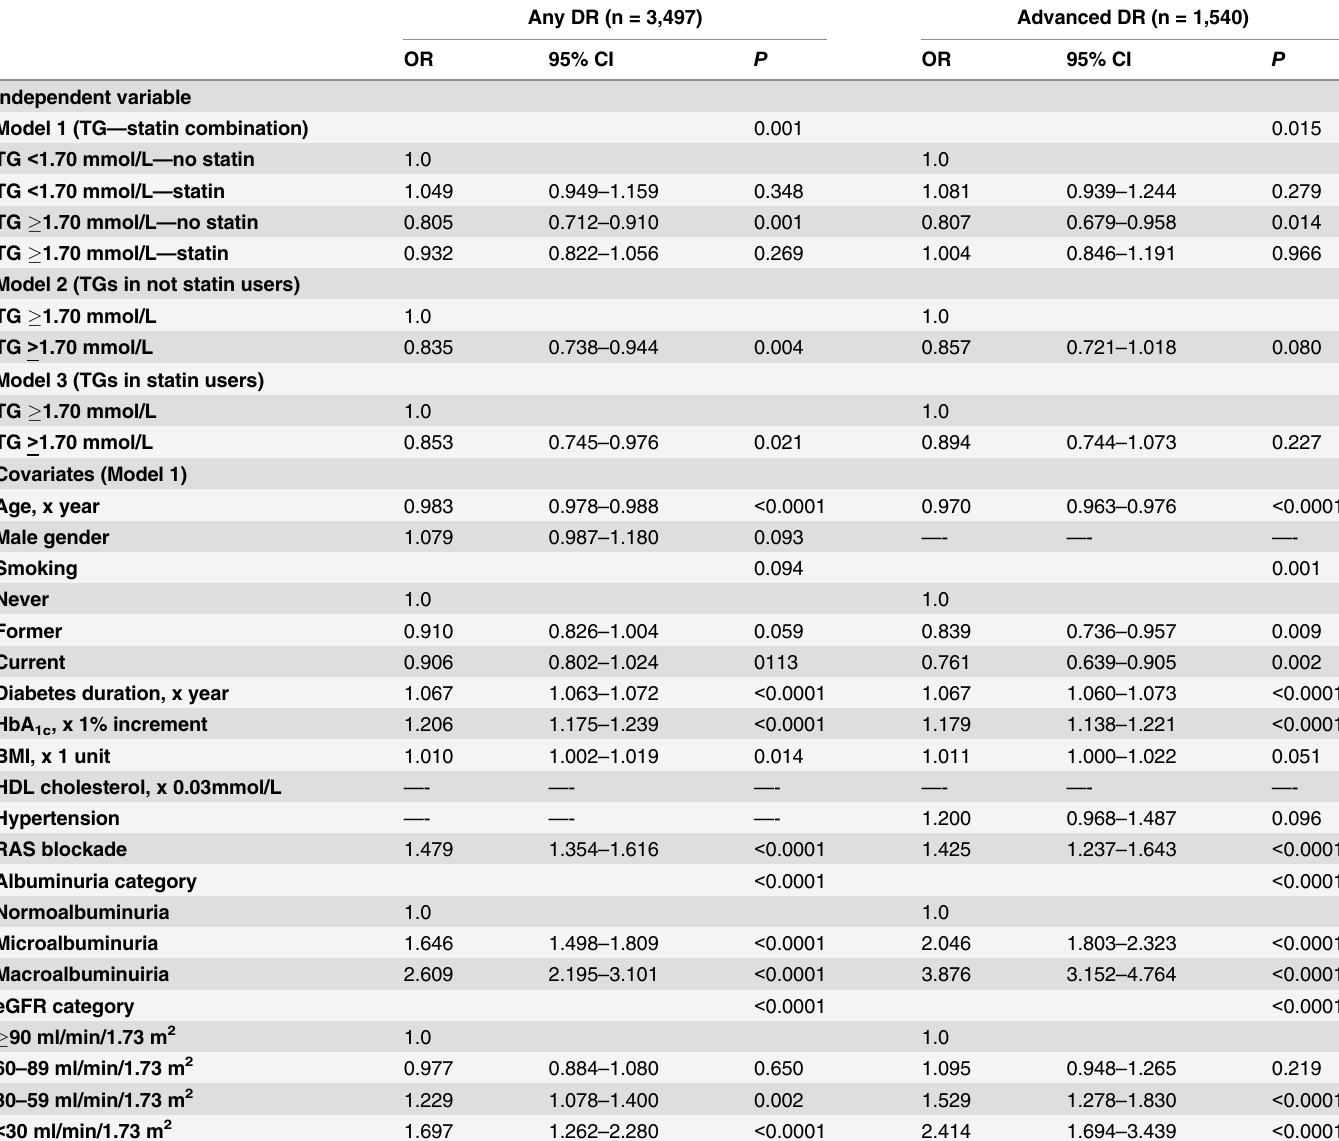
Table 4. Independent association of triglyceride levels and statin treatment with any and advanced DR in the RIACE study. * Any DR (n =